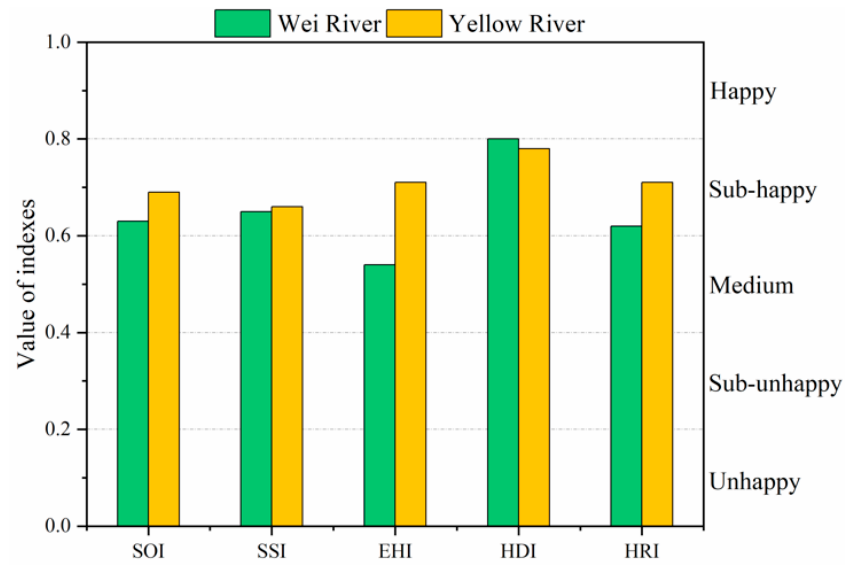
Figure 5. Results of the happy river evaluation of the Yellow and Wei Rivers.